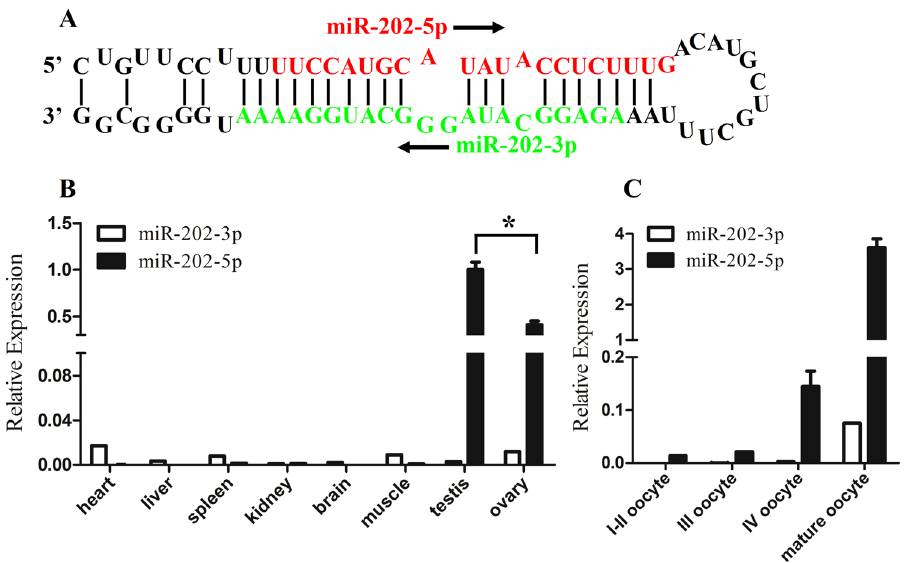
Figure 1. Tissue distribution pattern of miR-202 by RT-PCR. ( A ) Sequence of miR-202 including stem loop, miR-202-5p (in red) and miR-202-3p (in green). The arrow indicated the direction of miRNA sequences from 5 ′ -3 ′ . ( B ) Tissue distribution of miR-202-3p/5p. ( C ) Dynamic expression of miR-202-3p/5p in oocytes at different developmental stages. U6 was used as an internal control. Asterisk indicated significant difference ( p <